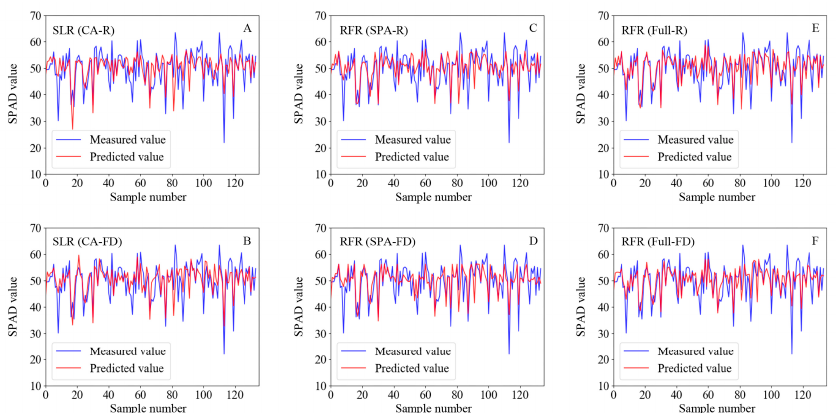
Figure 5. Comparison of predicted and measured values SPAD based on different data sets and models. ( A , B ) Simple linear regression (SLR) model based on CA-R and CA-FD; ( C , D ) random forest regression (RFR) model based on SPA-R and SPA-FD; ( E , F ) RFR model based on Full-R and Full-FD. CA-R/FD, reflectance/first derivative with the highest correlation with SPAD values; SPA-R/FD, reflectance/first derivative of a characteristic band extracted through SPA; Full-R/FD, full-band reflectance/first derivative. CK, control; DS, drought stress. The fi t of the SLR model established with the fi rst derivative at 735 nm (CA-FD) was